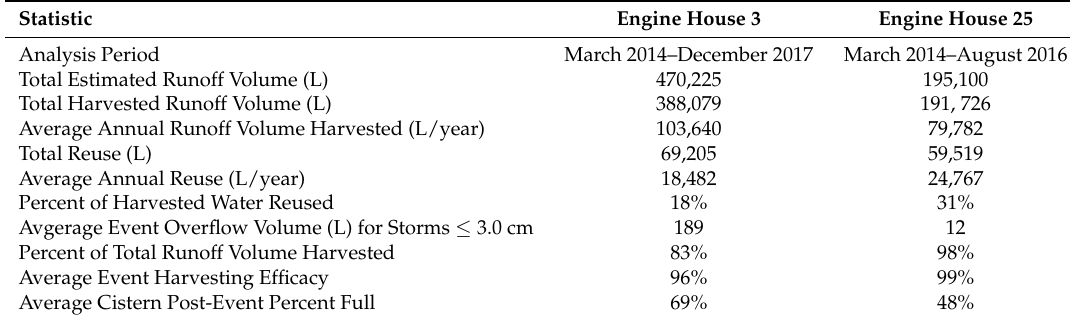
Table 1. Advanced rainwater harvesting (ARH) System Water Quantity Summary